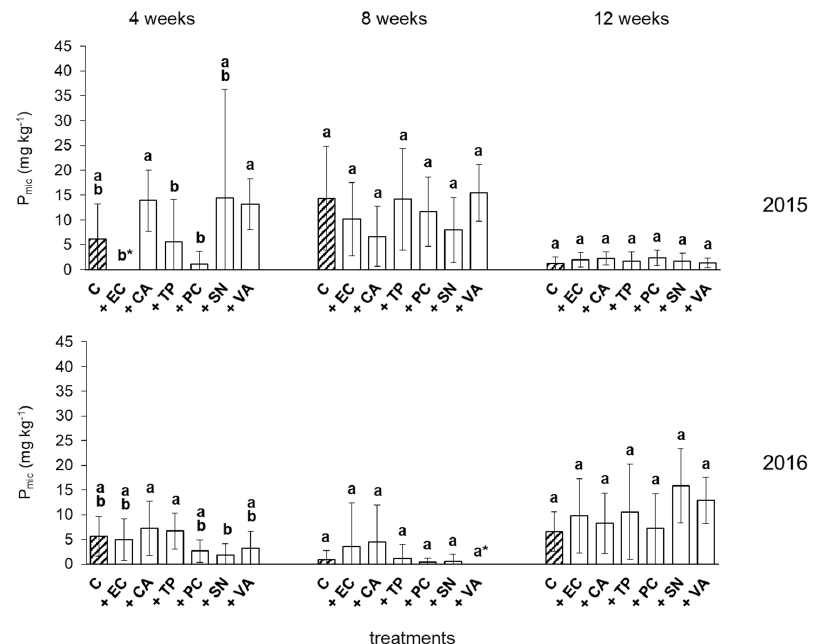
Figure 3. Content of microbial biomass P (P mic ) in soil (mg kg − 1 ) in weed-free growth (C) and mixed growth with weeds in dependence of the growth stage in a pot experiment (6 kg of a P deficient loamy sand per pot) under semi field conditions in 2015 and 2016. Values are expressed as means ± SD. Lower letters indicate significant differences ( p < 0.05, Kruskal-Wallis test, n = 42). (C: control, +EC: maize + Echinochloa crus-galli, +CA: maize + Chenopodium album , +TP: maize + Tripleurospermum perforatum , +PC: maize + Polygonum convolvulus , +SN: maize + Solanum nigrum , +VA: maize + Viola arvensis , * below level of